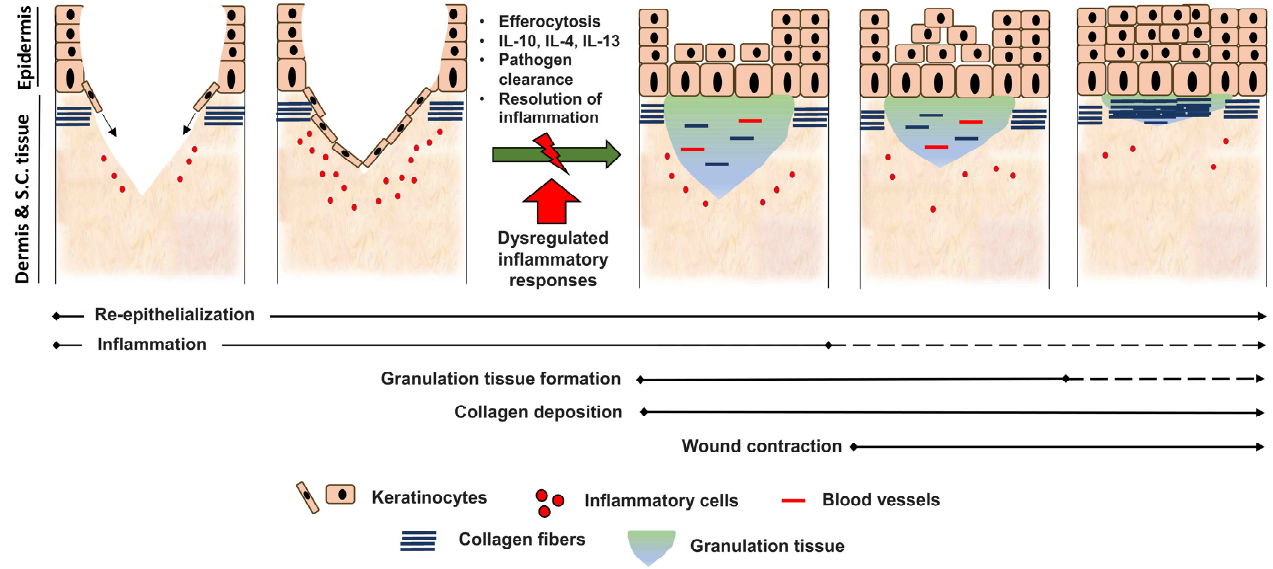
Figure 2. A classic wound healing model shows the importance of transitioning from the inflamma- tory to proliferative phases during the repair process. Normal wound healing typically progresses via activation of an innate immune program involving inflammatory cell recruitment. Anti-inflammatory responses are triggered through several mechanisms, including efferocytosis, to suppress inflammation and initiate repair events. These reparative phases comprise re-epithelialization, granulation tissue formation, angiogenesis and collagen deposition. Dysregulation of inflammatory responses in case of, for example, diabetes, aging and immunosuppressive diseases fail to transition to the proliferation phase, thereby inducing delayed wound healing or chronic injuries.